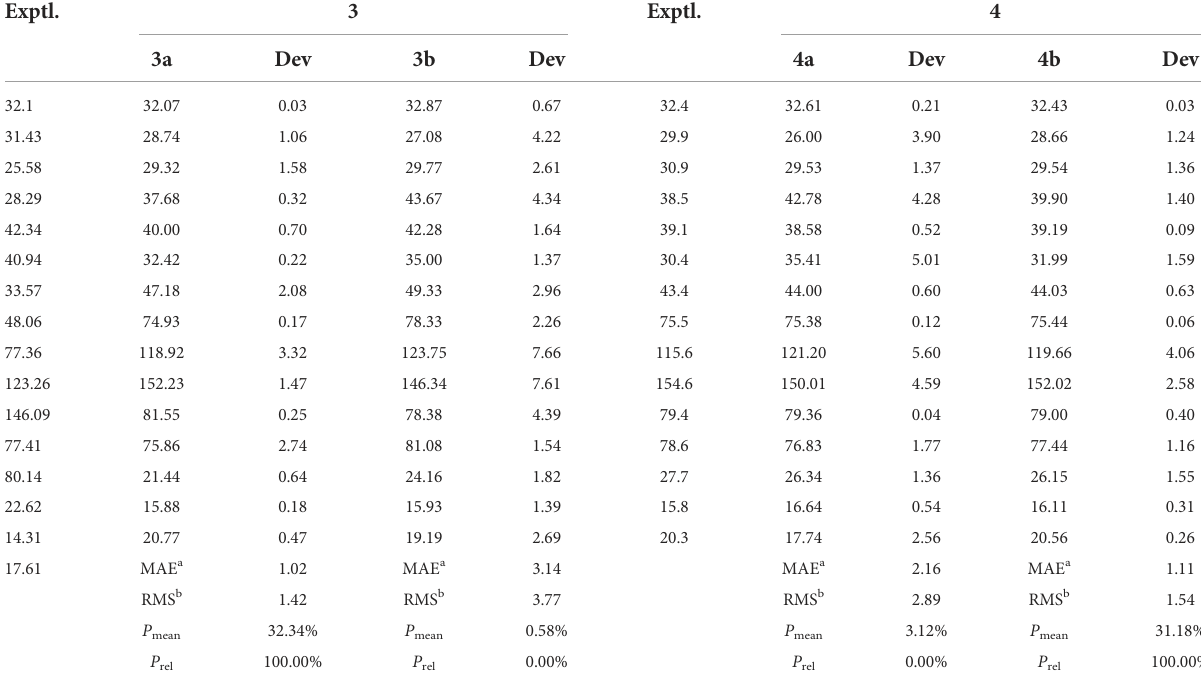
TABLE 2 Calculated 13 C chemical shifts (CDCl 3 ) fi tting with the experimental data of compounds 3a, 3b, 4a, and 4b following the STS protocol.